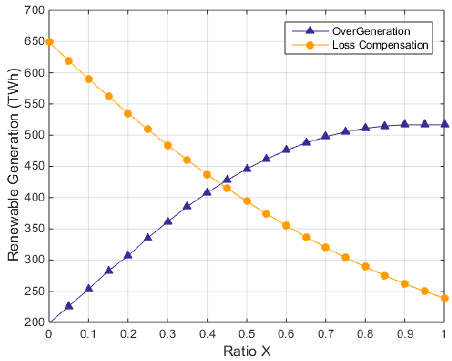
Figure 9. Variable components of renewable generation: loss compensation and over-generation. When all the storage capacity is provided by hydrogen ( X = 0), the system sees losses of approximately 650 TWh, which is equivalent to ~21% of the total demand. On the other hand, when the storage capacity in the system is provided entirely by CAES, energy losses reduce to ~8% of the total demand.